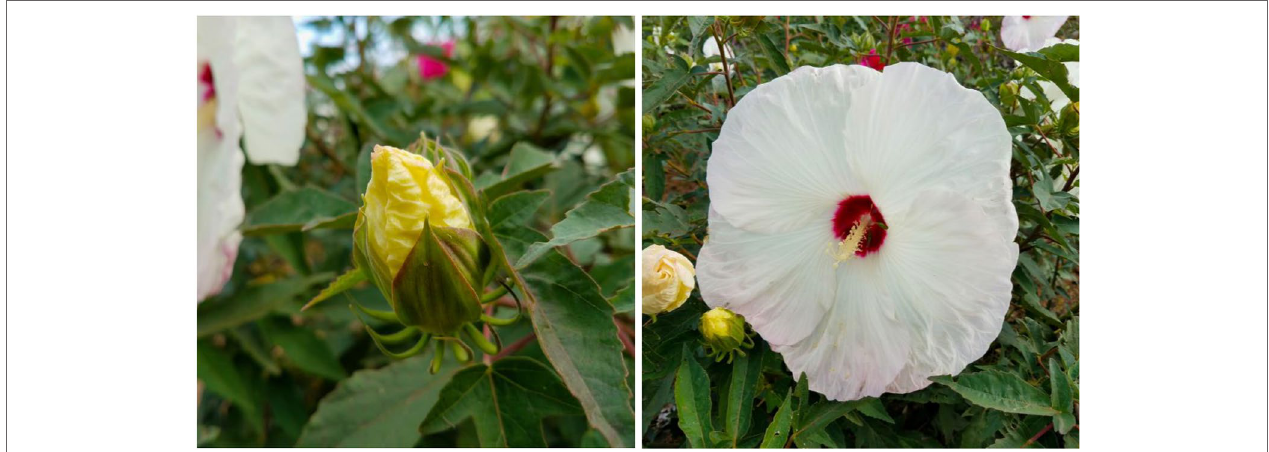
FIGURe 14 | Opening flower bud (left) and fully opened flower color of H. x moscheutos hybrid “180074-M1W”. Photo credits: Dariusz P. Malinowski.